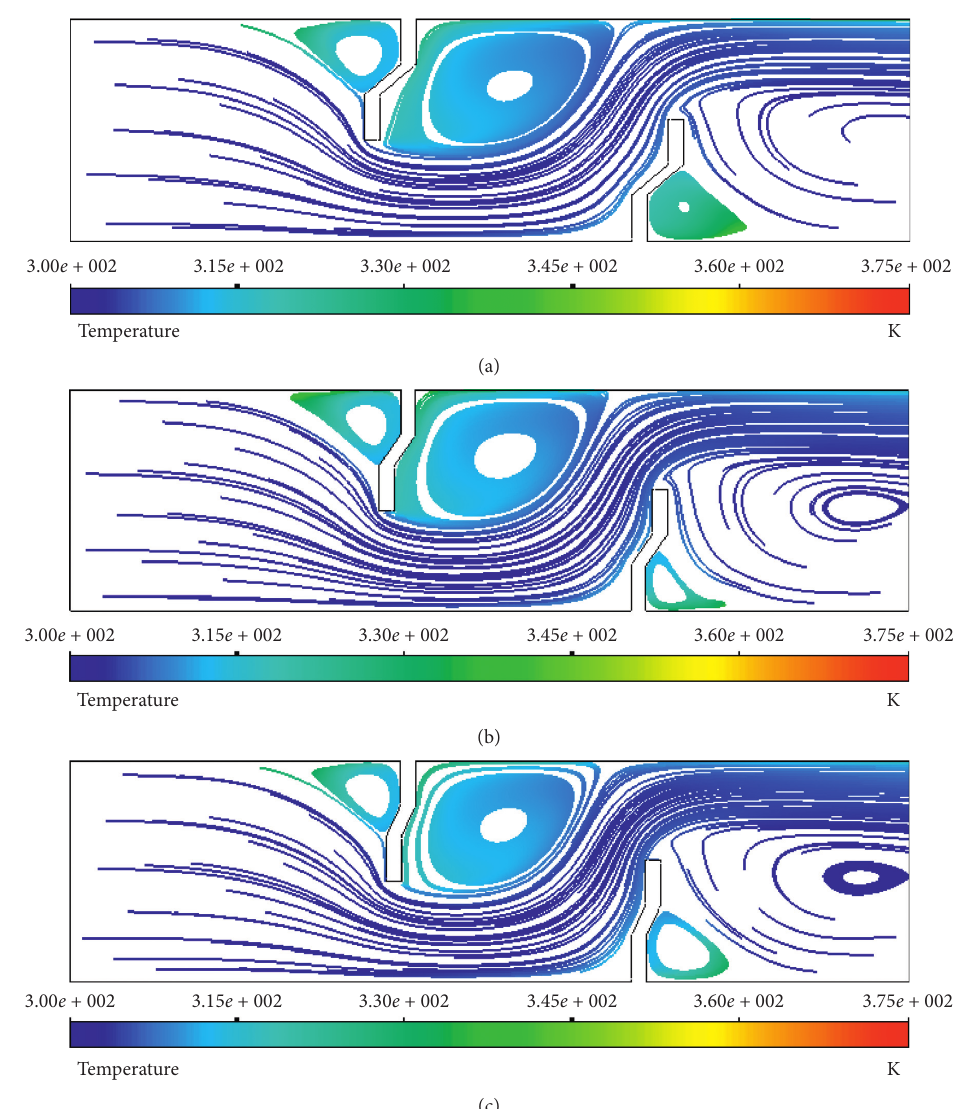
Figure 5: Isotherms for different values of inclination angles: (a) φ